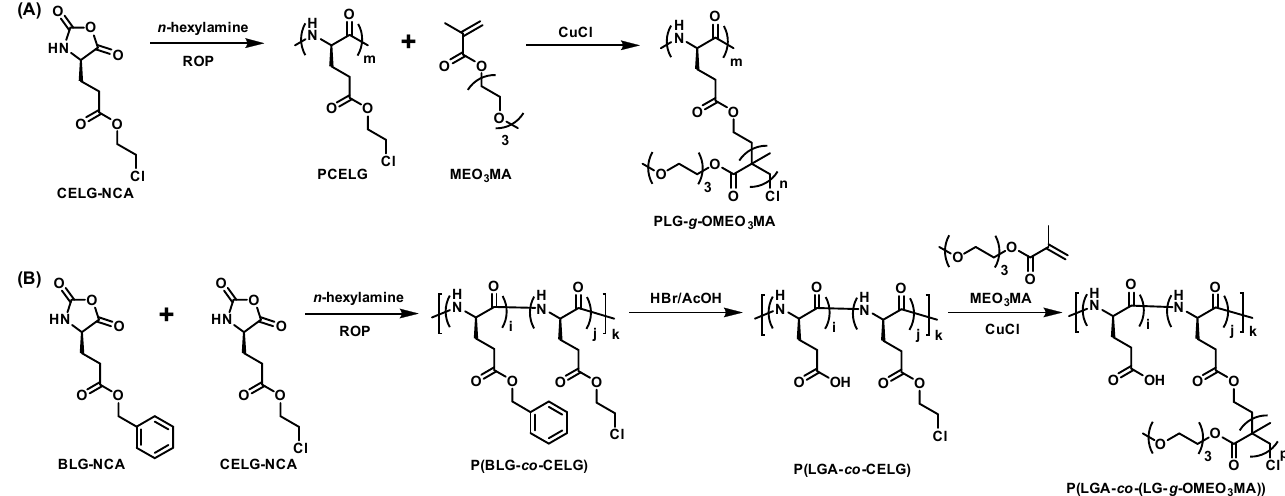
Figure 16. Synthetic routes of copolymers ( A ) PLG- g -OMEO 3 MA and ( B ) P(LGA- co -(LG- g -OMEO 3 MA)) by Chen et al. Reproduced with permission [38]. Copyright 2011, Wiley Periodicals, Inc.